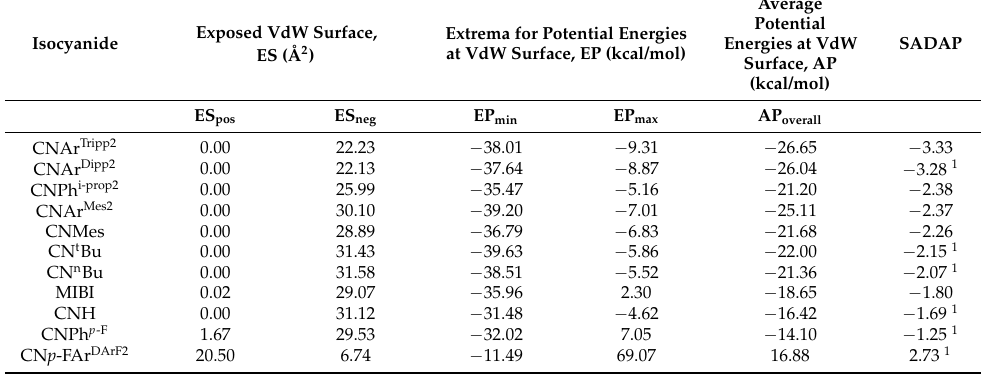
Table 1. Calculated electrostatic potential surface properties of the isocyanide carbon atom at the VdW boundary for structures optimized at the B3LYP/6-311++G** level. Surface properties were evaluated at ρ = 0.001 level using an electrostatic potential map basis with a grid-point spacing of 0.25. The last column contains the s urface- a veraged d onor a tom p otential SADAP = (EP min + EP max + AP)/(ES pos + ES neg ) as a combined descriptor of steric and electrostatic properties of the potential ligands, which allows an estimation of their reactivity (ES: exposed VdW surface, EP: minimum and maximum potential energy at the VdW surface, AP: averaged potential energy at the VdW surface). Average Potential Exposed VdW Surface, Extrema for Potential Energies Isocyanide Energies at VdW at VdW Surface, EP (kcal/mol) ES (Å 2 ) Surface, AP